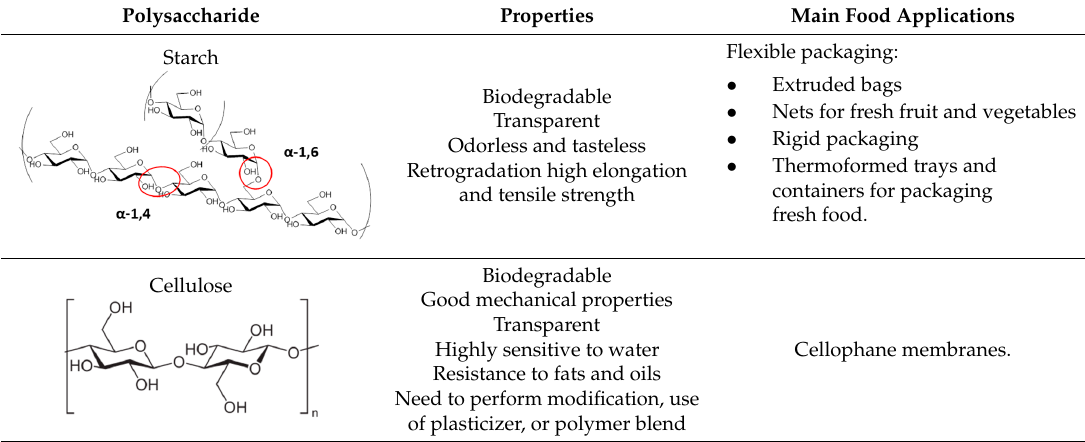
Table 3. Characteristics and food use of polysaccharides extracted from animals and vegetables [140].